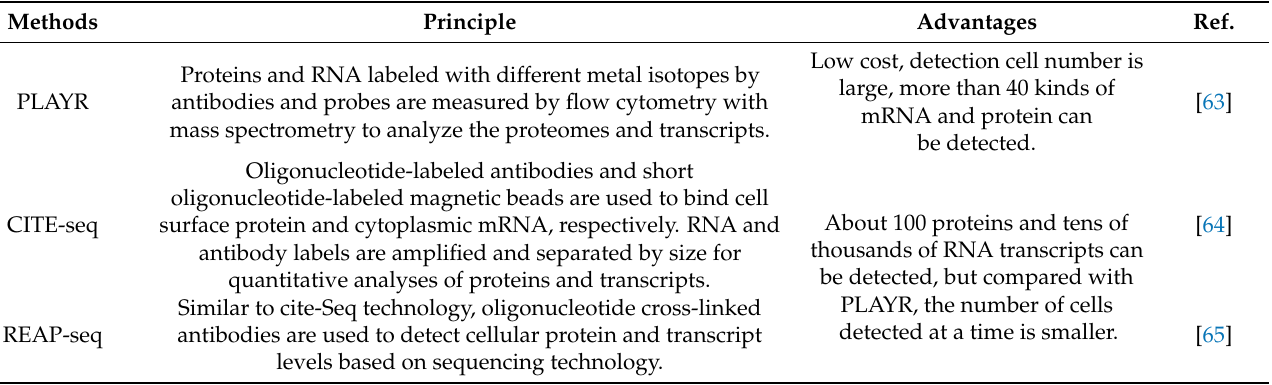
Table 6. Single-Cell Proteomic Analysis.